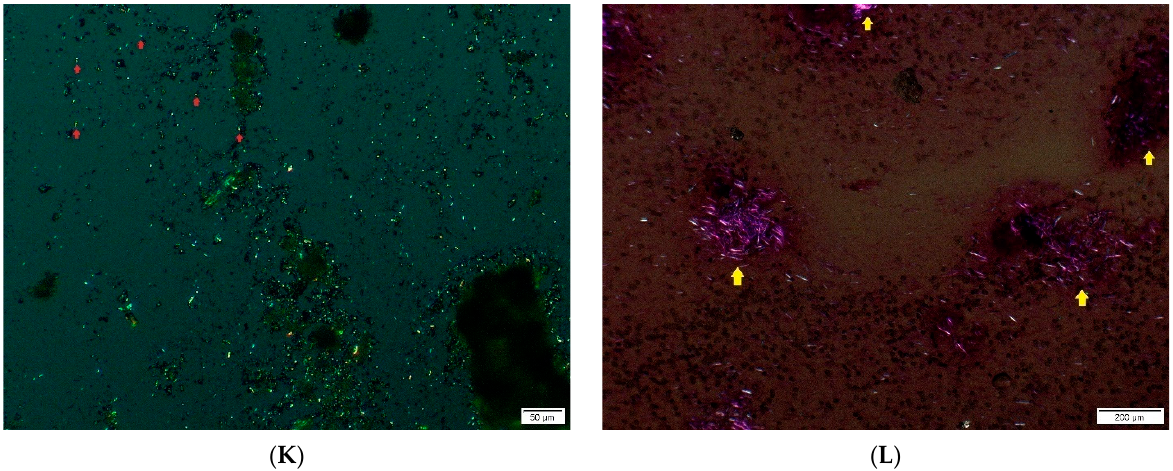
Figure 2. ( A ) Chameleon. Kidney. Gout tophi (black arrows) with severe granulomatous inflamma- tory reaction. HE, Ob. 4. ( B ) Poultry. Ureter cross section. Ureter ectasia and periuretral heterophillic infiltrate (black arrows). HE, Ob. 4. ( C ) Human. Severe granulomatous reaction within the joint capsule. Necrotic foci surrounded by multinucleated foreign body type cells (black arrows). Ob. 10. ( D ) Snake. Heart—cross section at the base of heart with several granulomatous foci involving the vascular wall (black arrows), HE Ob. 2. ( E ) Snake. Heart—Similar cross section–granulomatous foci (black arrows), Von Kossa Ob. 4. ( F ) Poultry. Ureter cross section. Diffuse negative content with discrete black Von Kossa positive material (black arrows). Von Kossa, Ob. 4. ( G ) Human. Joint capsule cross section. Von Kossa. Ob. 4. ( H ) Snake. Heart—Similar cross section–granulomatous foci (black arrows), Gomori Ob. 4. ( I ) Chameleon. Native smear from cloaca content. Different sized black crystals in light microscopy. Ob. 4. ( J ) Poultry. Native smear from ureter, polarized light, Ob. 10. ( K ) Chameleon. Native smear from ureter content, crystals in polarized light–(red arrows). Ob. 10. ( L ) Human. Native smear from joint content. Crystals in polarized light (yellow arrows). Ob. 4.